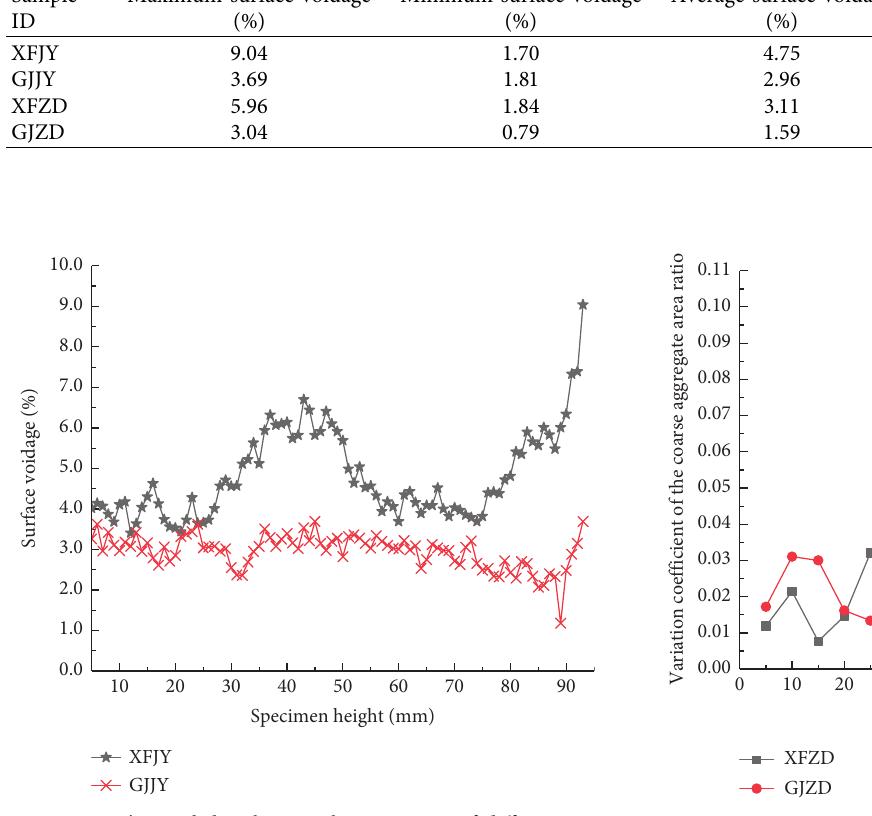
Figure 13: The variation coefficient of the coarse aggregate area ratio under vibration compaction.